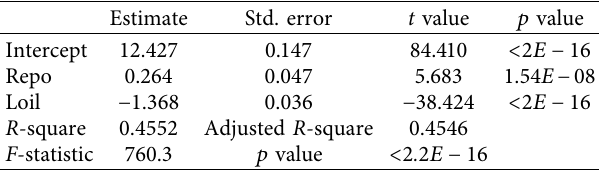
Table 4: The multiple